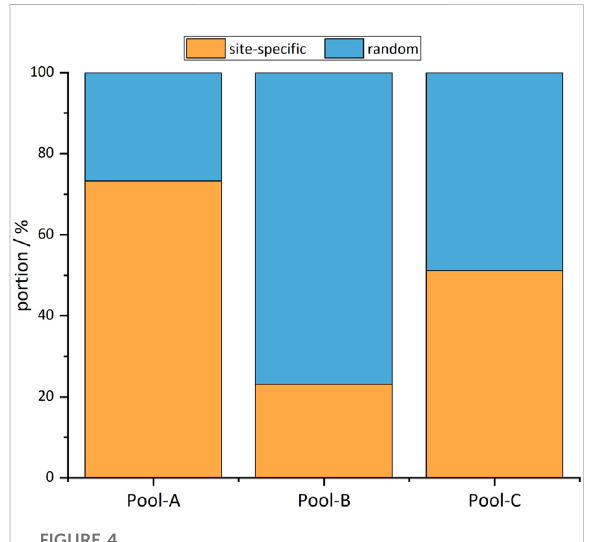
FIGURE 4 Portions of reads mapping to the intended integration site (site-speci fi c) and random locations.